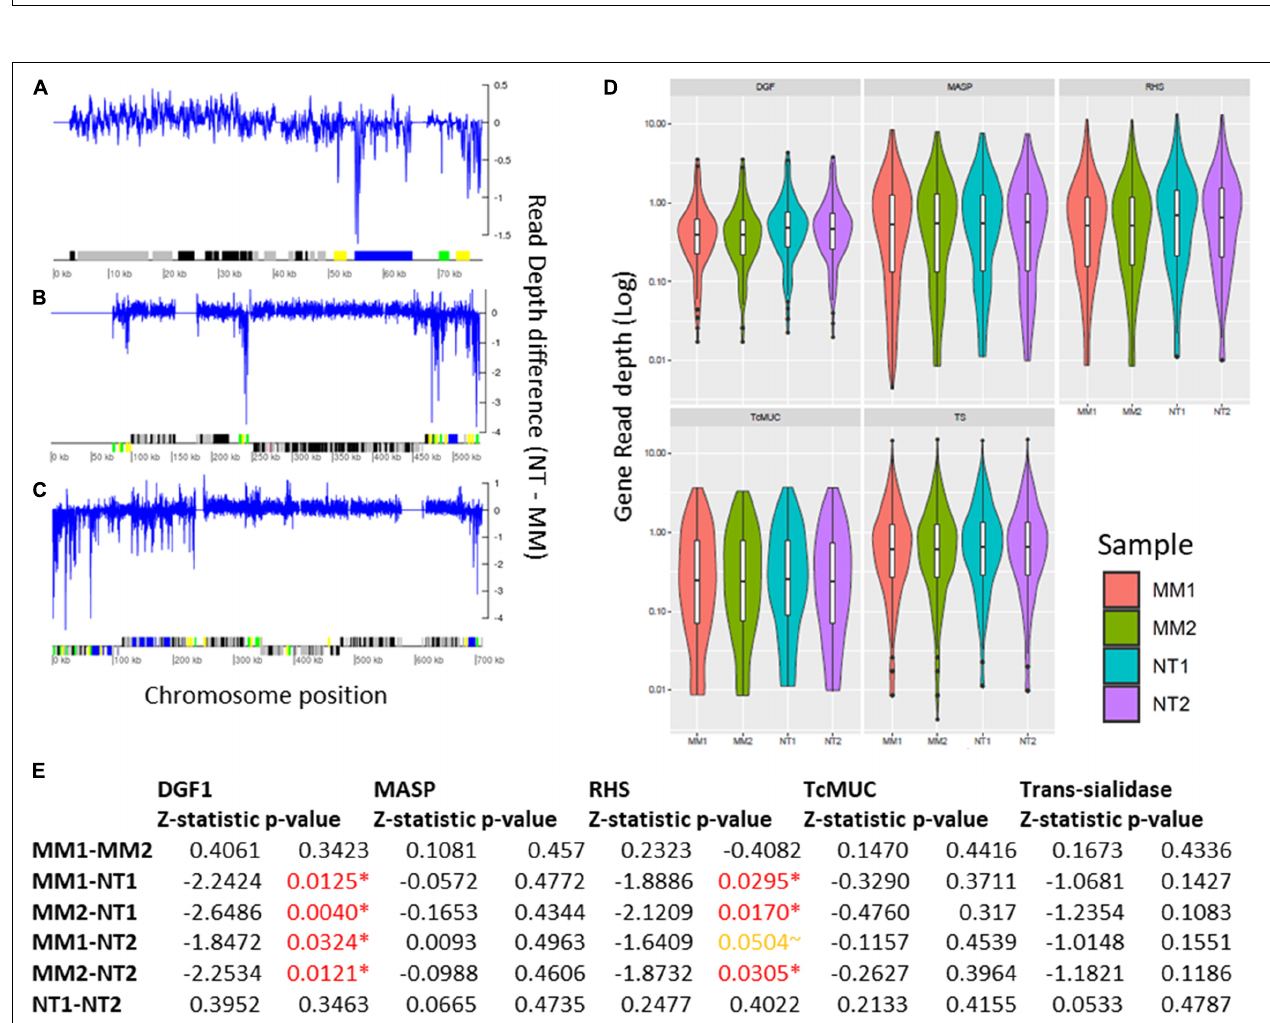
FIGURE 7 | Impact of MMS treatment in segmental and gene duplication/loss in TcTopo3 α KO cells. Segmental duplications in Chromosomes 1 (A) , 12 (B) , and 22 (C) . In this image, the blue line corresponds to the difference between the read depth of NT (1–2) and MM (1–2) across the whole chromosome sequence, where values above and below zero correspond, respectively, to increase copies in MM (1–2) and NT (1–2). Below, protein-coding genes are depicted as rectangles drawn in proportion to their length, and their coding strand is indicated by their position above (top strand) or below (bottom strand) the central line. Colored boxes represent: DGF-1 (blue); GP63 (Pink); MASP (brown); RHS (green); and Trans-sialidase (yellow); hypothetical genes (black); or other genes (gray). Gaps are represented by gene-less regions with no read coverage. (D) Violin plot representing the gene copy number of DGF-1, MASP, RHS, TcMUC, and Trans-Sialidase genes. The Y -axis represents the distribution of gene coverages, in log scale. MM1 (red), MM2 (green), NT1 (blue), and NT2 (purple). (E) Z-statistic and p -values of Dunn’s test between the comparisons of DGF-1, MASP, RHS, TcMUC, and trans-sialidase gene coverages. P -values < 0.05 are highlighted in red, and p -values ∼ 0.05 are highlighted in orange. There was a significant reduction in the DGF-1 and RHS copy numbers in MMS-treated TcTopo3 α KO isolates.